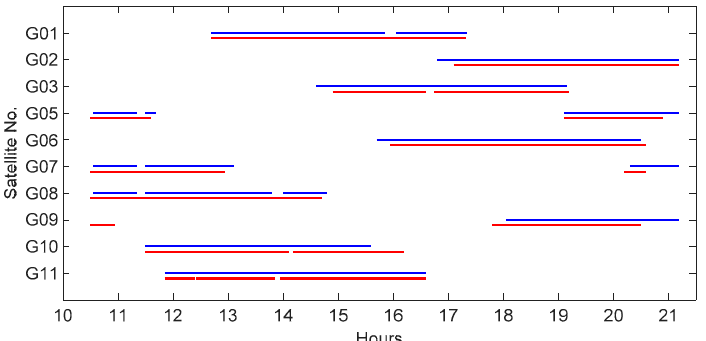
Figure 9. The satellite visibility tracked by the reference station FD83 (blue) and the rover AIR2 (red). Only 10 satellites are shown here. Receivers losing track of the satellites may introduce biases in the DD